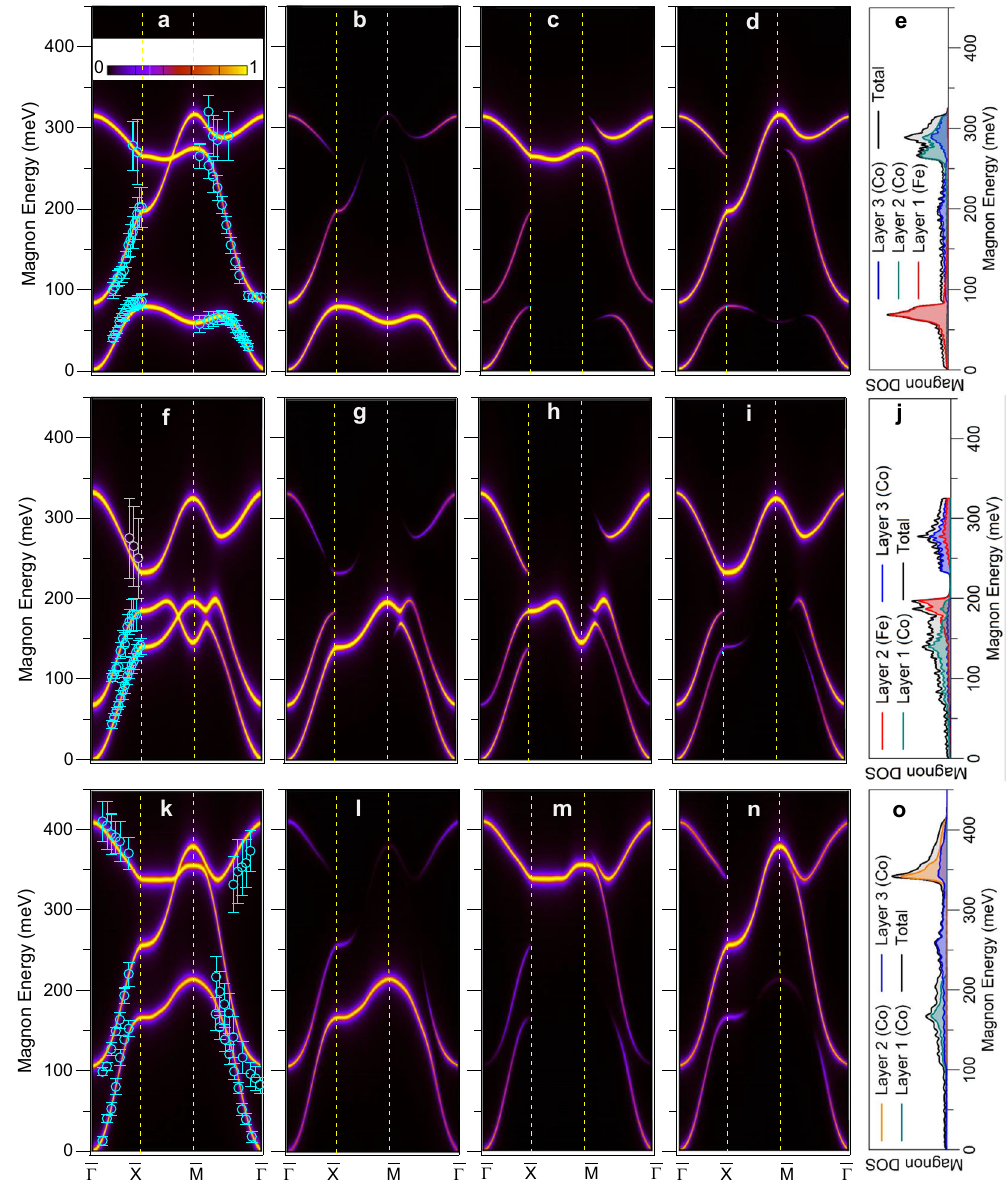
Fig. 3 The magnon Bloch spectral function and density of magnonic states (DOS) of different layered structures. Co/Co/Fe ( a – e ), Co/Fe/Co ( f – j ), and Co/Co/Co ( k – o ). The total Bloch spectral function of Co/Co/Fe is presented in panel ( a ) and the projected Bloch spectral function into the interface, middle, and surface layer is shown in panels ( b , c , and d ), respectively. The total and layer-resolved magnon density of states are shown in panel ( e ). The total Bloch spectral function of Co/Fe/Co is presented in panel ( f ) and the projected Bloch spectral function into the interface, middle, and surface layer is shown in panels ( g , h , and i ), respectively. The total and layer-resolved magnon density of states are shown in panel ( j ). The total Bloch spectral function of Co/Co/Co is presented in panel ( k ) and the projected Bloch spectral function into the interface, middle, and surface layer is shown in panels ( l , m , and n ), respectively. The total and layer-resolved magnon density of states are shown in panel ( o ). The experimental data are shown by the symbols. The data shown by the cyan color are based on the analysis of the difference spectra. The data represented by the light-gray color are based on the analysis of the asymmetry spectra. The error bars represent both the statistical and systematic uncertainties (see “ Methods ” section). In all panels, (cid:1) Γ , (cid:1) X, and (cid:1) M represent the high symmetry points of the surface Brillouin